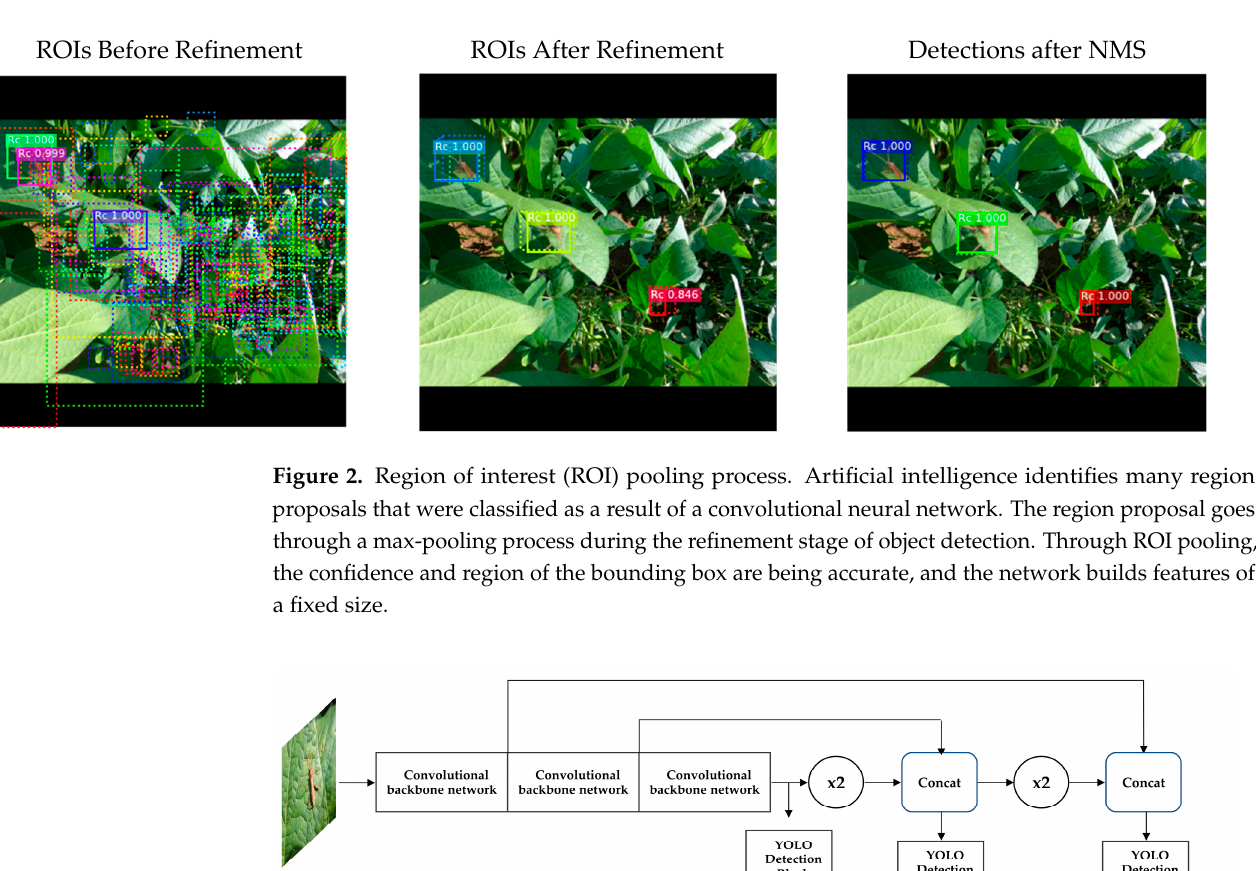
Figure 2. Region of interest (ROI) pooling process. Artificial intelligence identifies many region pro- posals that were classified as a result of a convolutional neural network. The region proposal goes through a max-pooling process during the refinement stage of object detection. Through ROI pool- ing, the confidence and region of the bounding box are being accurate, and the network builds fea- tures of a fixed size.